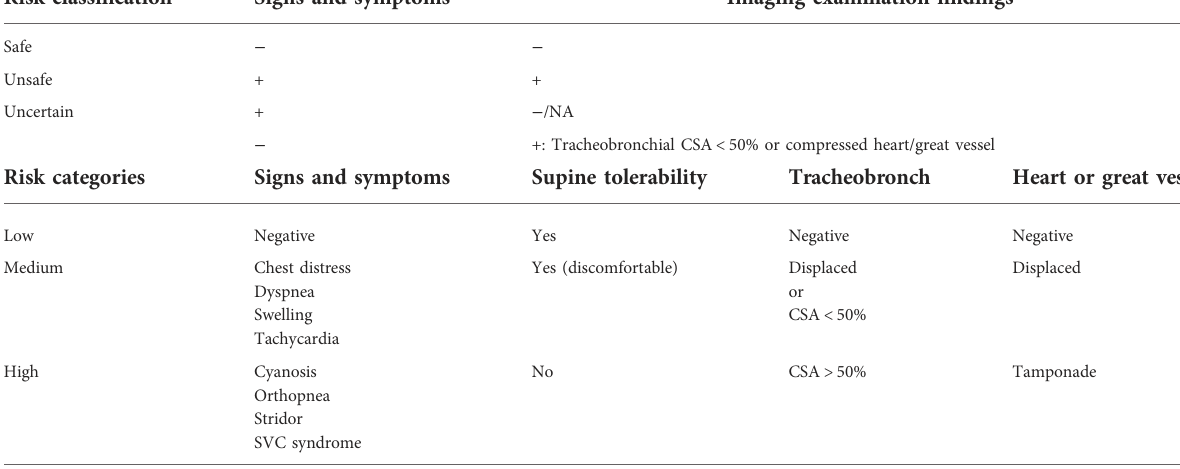
TABLE 2 Risk classi fi cation & categories of mediastinal mass